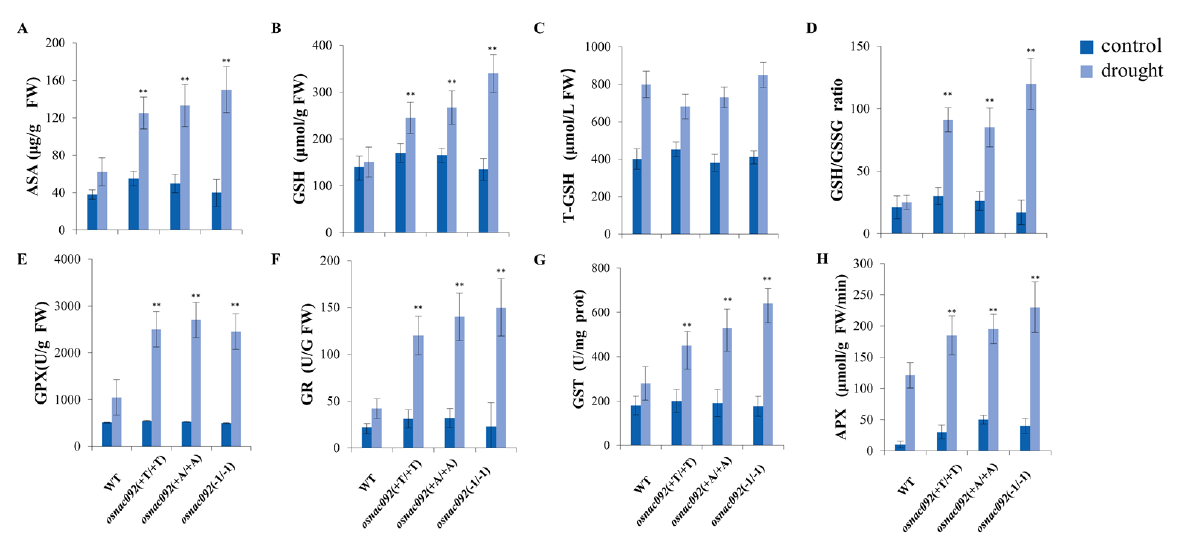
Figure 6. Antioxidant contents and activity of enzymes in the ascorbate-glutathione cycle were shown in wide type (WT) and osnac092 mutant plants. ( A ) ASA. ( B ) GSH content. ( C ) T-GSH content. ( D ) the ratio of GSH/GSSG. ( E ) GPX. ( F ) GR. ( G ) GST. ( H ) APX. ** represent significant differences at p < 0.01 compared with wide type. The detection of antioxidant contents and activity of enzymes 8-week-old WT and mutants under 14 days drought treatment.